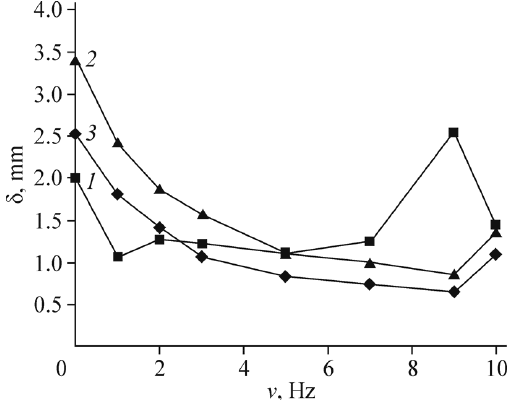
Figure 11. Frequency dependencies of the actuator displacement amplitude for Nafion membranes with (1) Pt electrodes and (2) composite Ag/graphene electrodes with the same silver content as in [31]; (3) results of [31]. The voltage amplitude is 1 V. Reproduced from [32] with permission from Springer Nature. Copyright 2018.